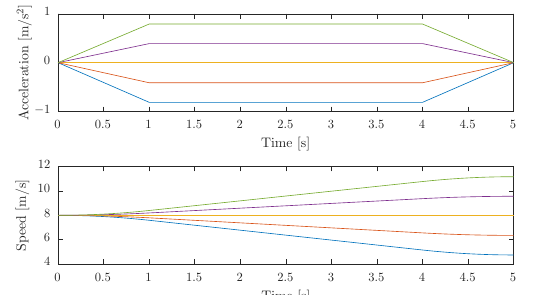
Figure 3: Example of 5 speed trajectories with ramp time 1 s, and maneuver and step time lengths 𝑇 ramp = 𝑇 𝑇 = 5 s. Acceleration is shown in the 𝑈 = top plot, while speed is shown in the bottom plot. Courtesy of (Eriksen et al., 2019b).